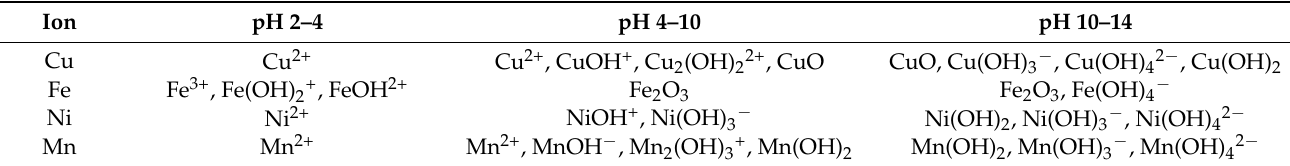
Table 5. pH ranges and corresponding species (by MEDUSA